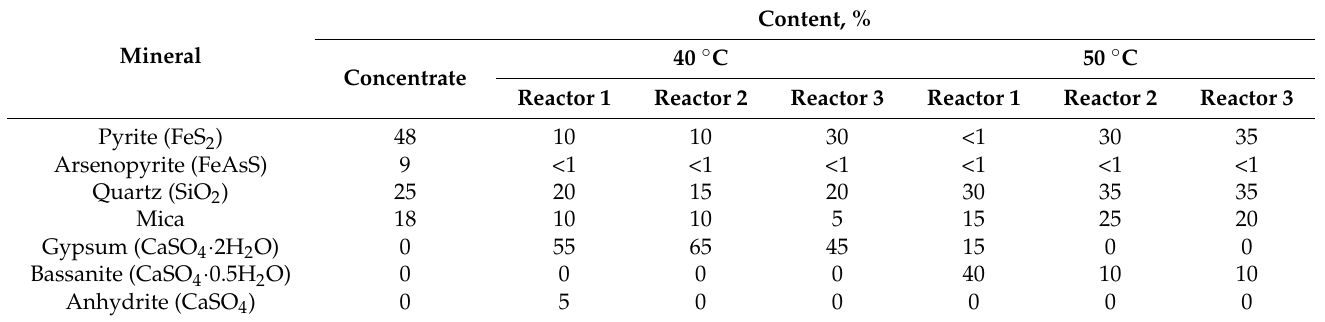
Table 5. Mineral composition of the concentrate and bio-oxidation residues (XRD).